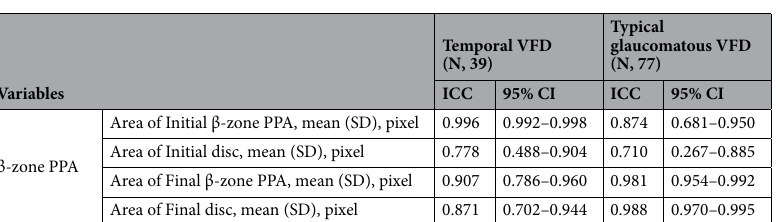
Table 2. Reliability of β-zone PPA parameters. VFD visual field defect, ICC intraclass correlation coefficient, PPA peripapillary atrophy. Reproducibility of β-zone PPA parameters: excellent for areas of initial and final β-zone PPA of both groups, final disc areas of both groups, and initial disc area of temporal VFD group; moderate for initial disc area of typical glaucomatous VFD group.